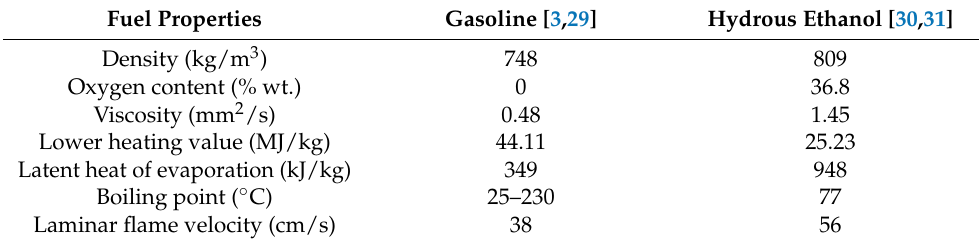
Table 1. Physical and chemical properties of test fuels.